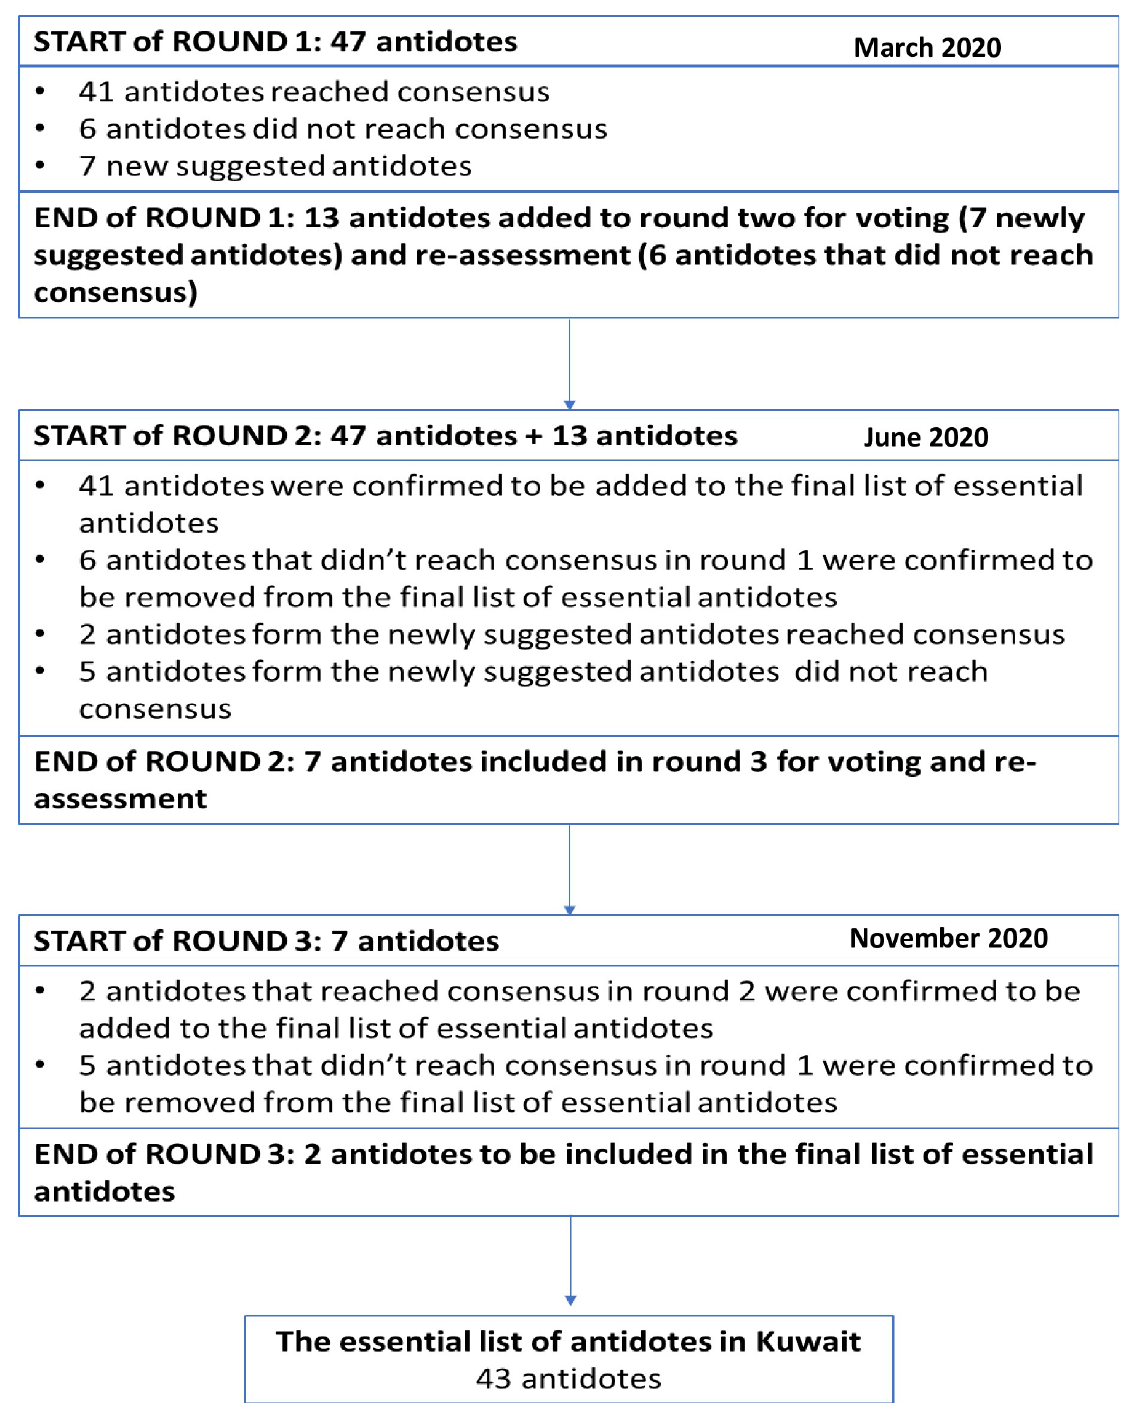
Fig 1. Step-by-step process of developing the expert consensus list of essential